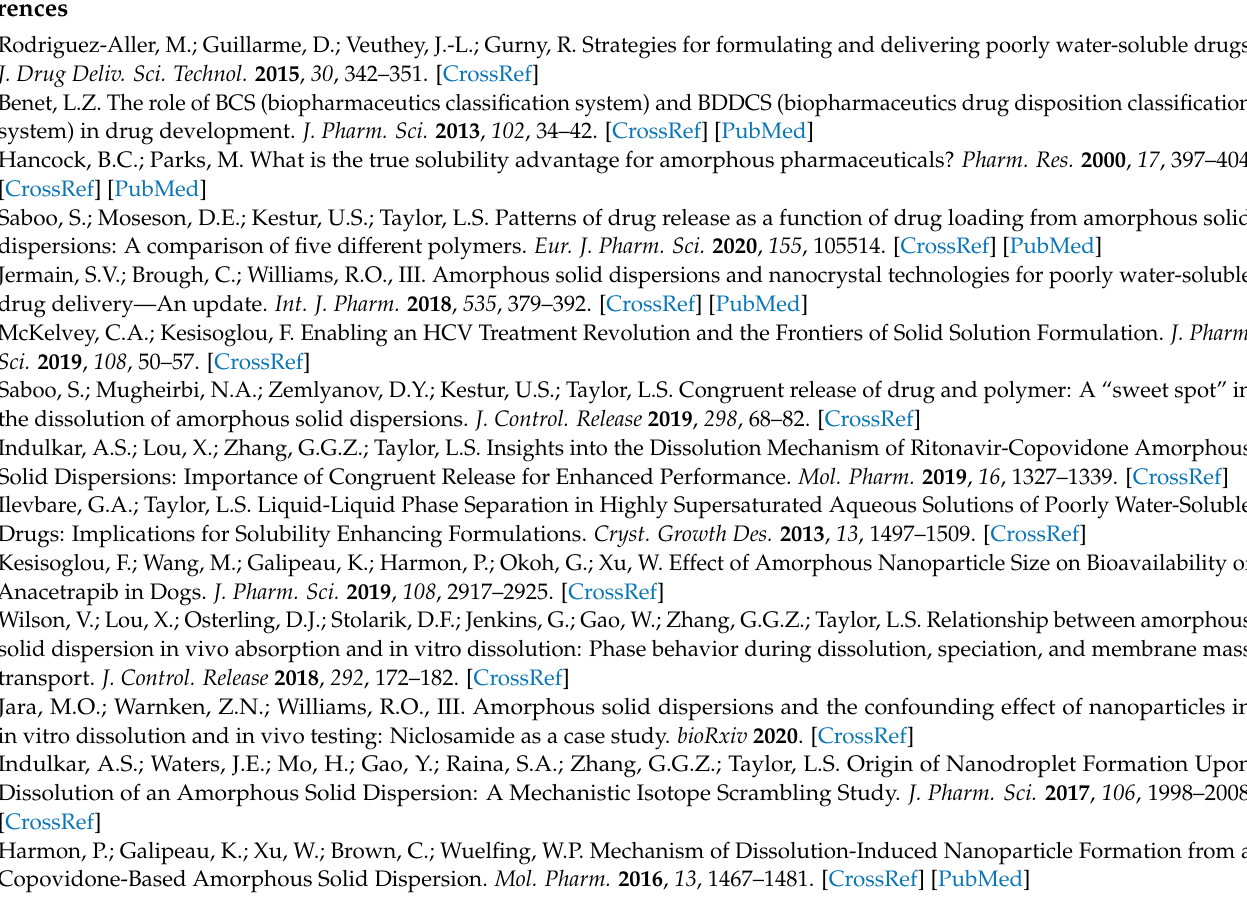
felodipine, Table S2: ASD compositions studied/referenced in this work, Figure S1: CMC of TPGS as determined by solubility measurement, Figure S2: CMC of TPGS as determined by pyrene fluorescence method, Figure S3: Surface normalized dissolution rates of drug, polymer and TPGS for 2% and 10% TPGS containing ternary ASDs, Figure S4: Representative DLS data, Figure S5: Representative AFM topographical images of initially prepared